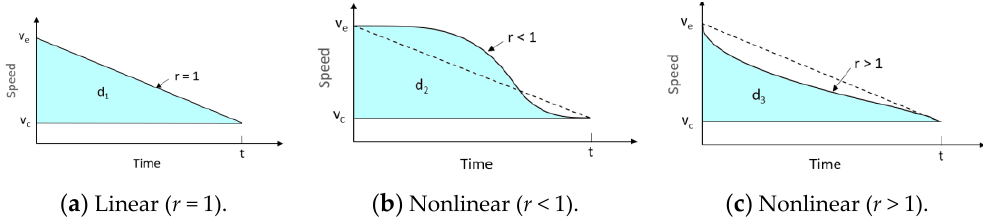
( a ) Linear ( r = 1). ( b ) Nonlinear ( r < 1). ( c ) Nonlinear ( r > 1). Figure 1. Illustration of linear and nonlinear deceleration profiles. ( a ) Linear ( r = 1); ( b ) Nonlinear ( r < 1); ( c ) Nonlinear ( r > 1).